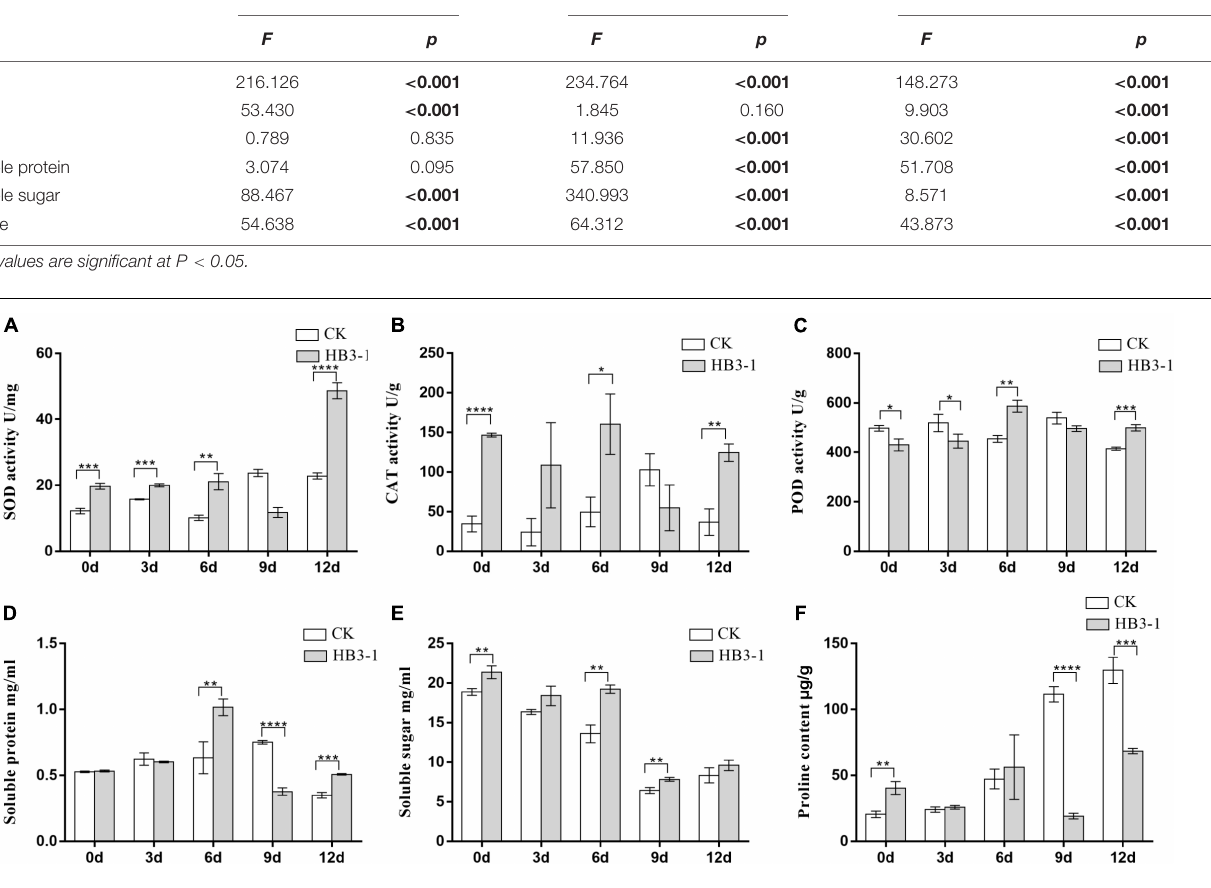
TABLE 2 | Effect of inoculation with HB3-1 (inoculation vs. control) and culture time on physiological indexes of Coelogyne viscosa seedlings. Extracellular enzyme